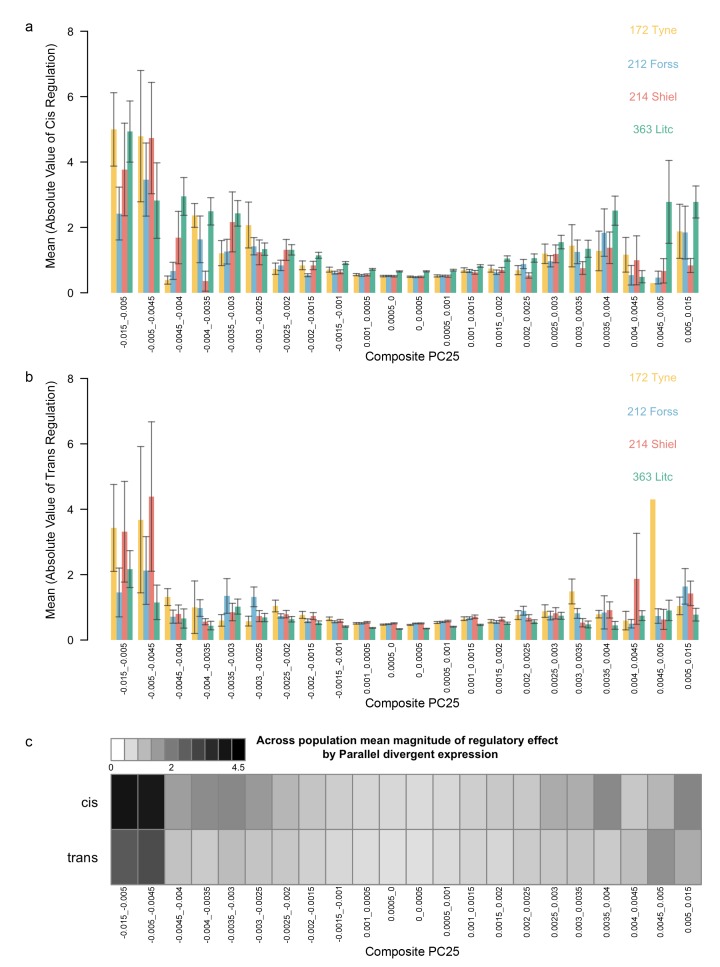
Mean magnitude of cis- (a) and trans- (b) regulation relative to parallel divergence in gene expression measured by composite PC.For each population studied for allele-specific expression, loci were binned according to their loadings on the composite PC describing parallel divergence in gene expression of pure strains. For each bin and each population, the mean and standard error of the quantitative degree of cis-regulation and trans-regulation was calculated (see main text). (c) As per Figure 5c in main text. For each bin, the mean across populations was calculated and plotted as a heat map with darker gray representing larger magnitudes of cis- and trans- effects.